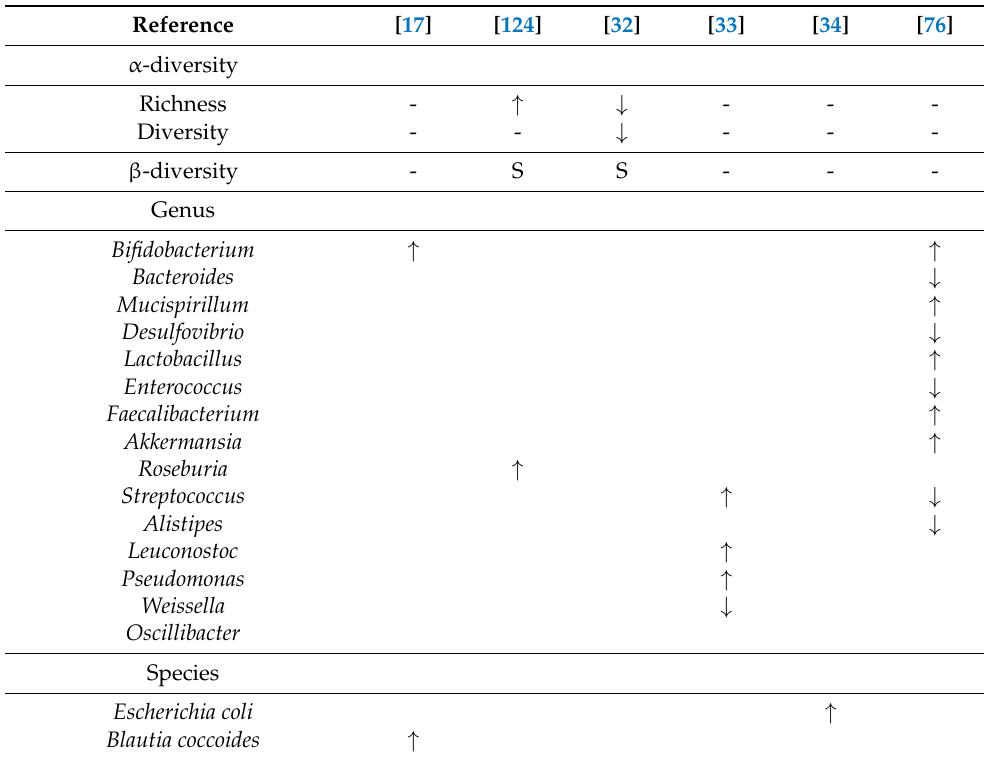
Table 3. The impact of maltodextrin on gut